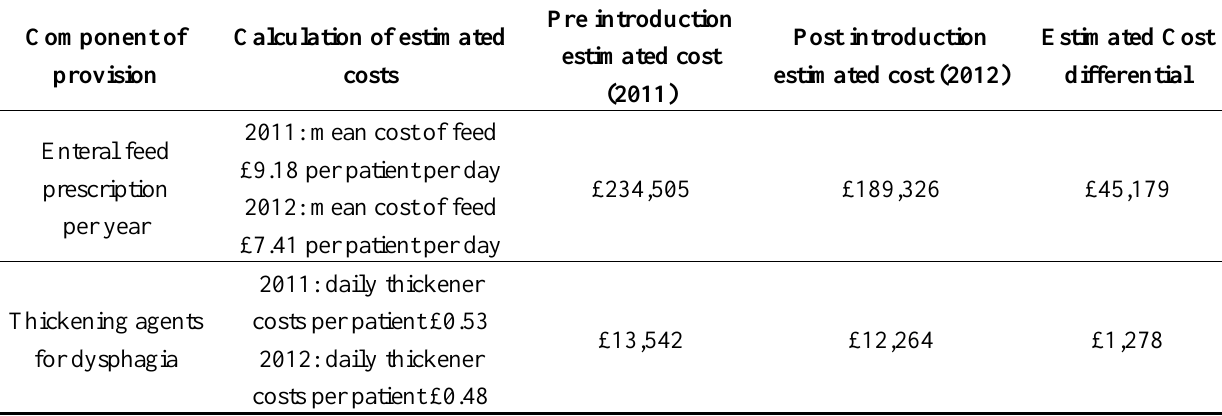
Table 2. Estimated costs pre and post introduction of the Home Enteral Nutrition Team ( n =